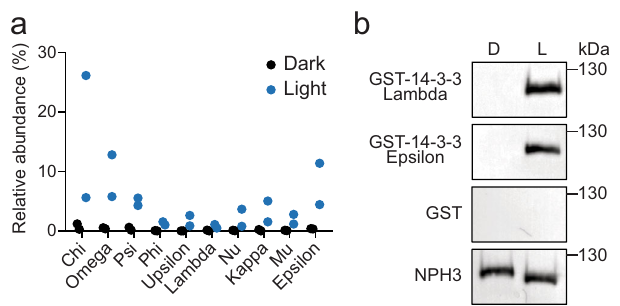
Fig. 1 NPH3 interacts with 14-3-3 proteins in a light-dependent manner. a NPH3-interacting proteins were identi fi ed by mass spectrometry analysis of anti-GFP immunoprecipitations from etiolated seedlings expressing GFP- NPH3 maintained in darkness (dark) or irradiated with 20 µ mol m − 2 s − 1 of blue light for 15 min (Light). Protein signal intensities were converted to the relative abundance of the bait protein (GFP-NPH3). Values from two independent biologicals replicates are shown. b Far-western blot analysis of anti-GFP immunoprecipitations from etiolated seedlings expressing GFP- NPH3 maintained in darkness (D) or irradiated with 20 µ mol m − 2 s − 1 of blue light for 15 min (L). GST-tagged 14-3-3 isoforms (Lambda and Epsilon) or GST alone were used as probes. Blots were probed with anti-GFP antibodies as a loading control (bottom